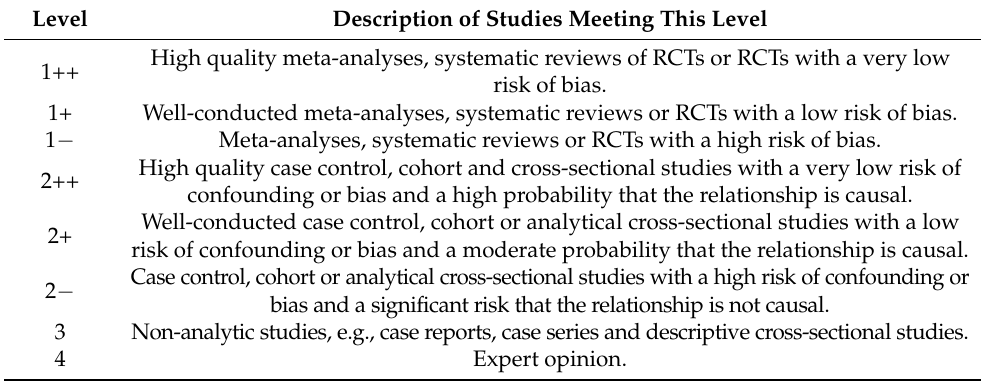
Table 1. The hierarchy of evidence utilized in this systematic review, amended from